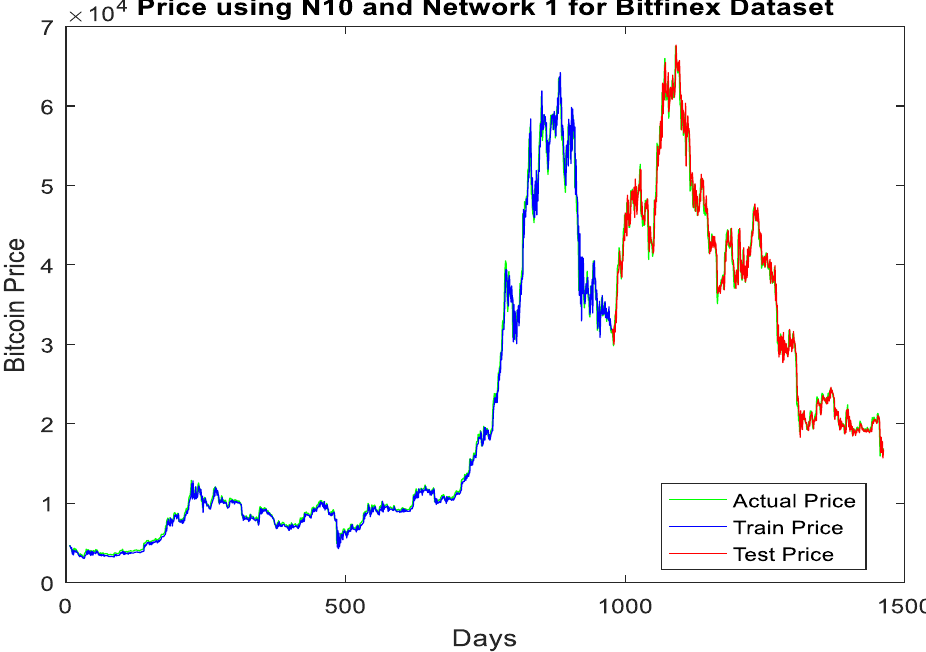
Figure 6. Training, testing and actual Bitcoin price of Legendre-based neural network model using the proposed dual normalized Bitfinex dataset .